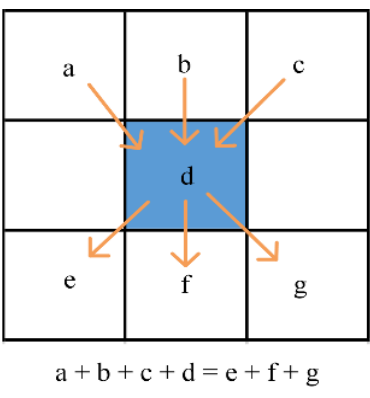
Figure 2 . the principle of mass conservation at pixel level. According to Figure 2, for application of the morphological method in two-dimensions, cell-by-cell sediment routing is required (S. Lane et al., 1995). Here, we use a multiple flow direction model (Holmgren, 1994) to route the sediment